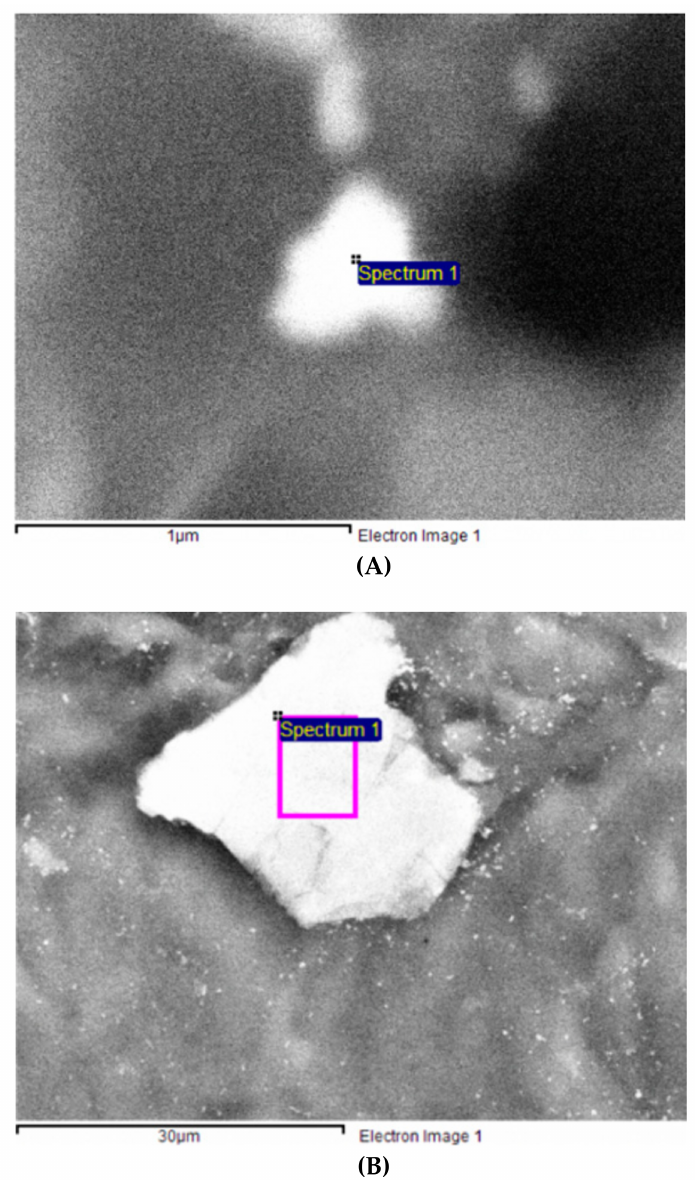
Figure 4. SEM images for ( A ) Fe(III)-DFO@EVOH and ( B )